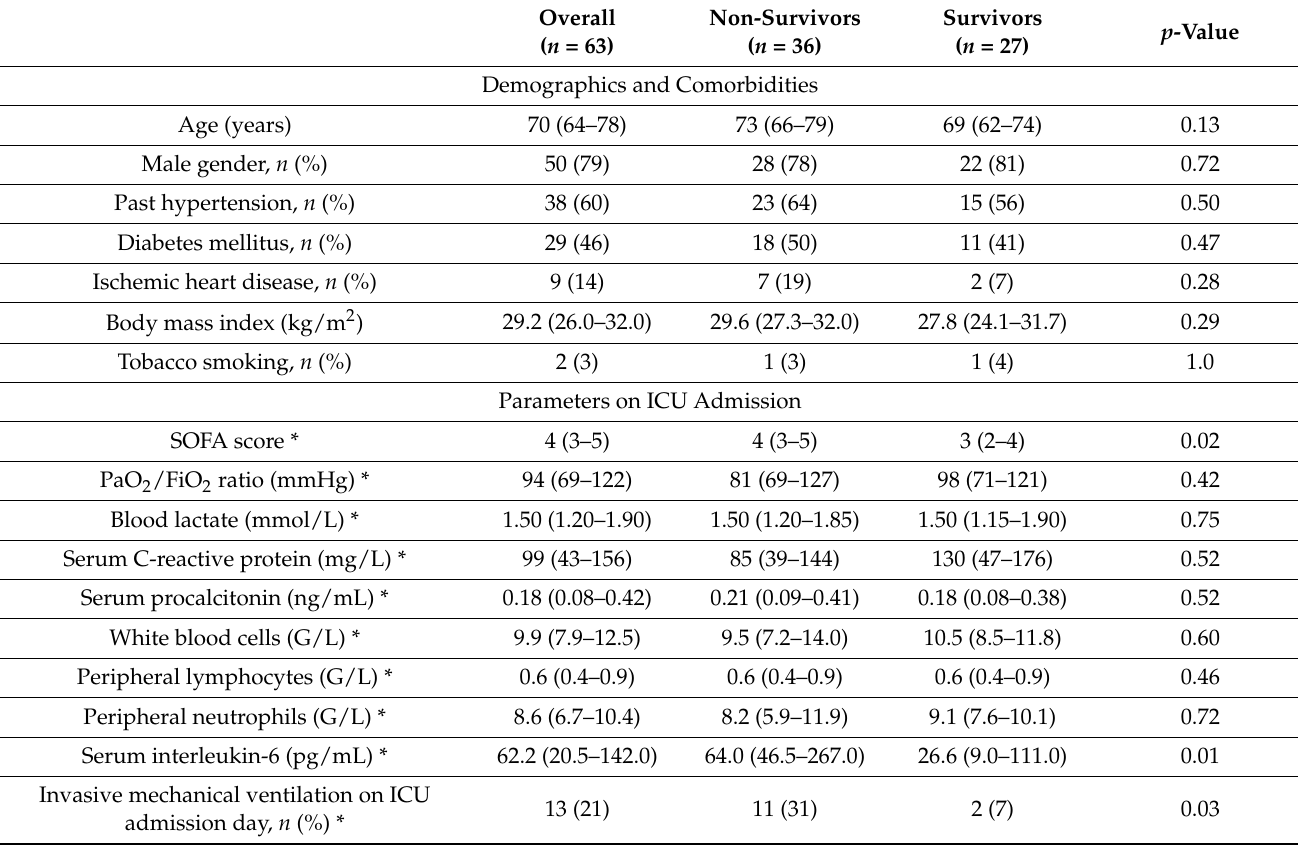
Table 4. Comparisons between survivors and non-survivors among the 63 critically ill patients treated with corticosteroids before admission to the intensive care unit (Cb-group